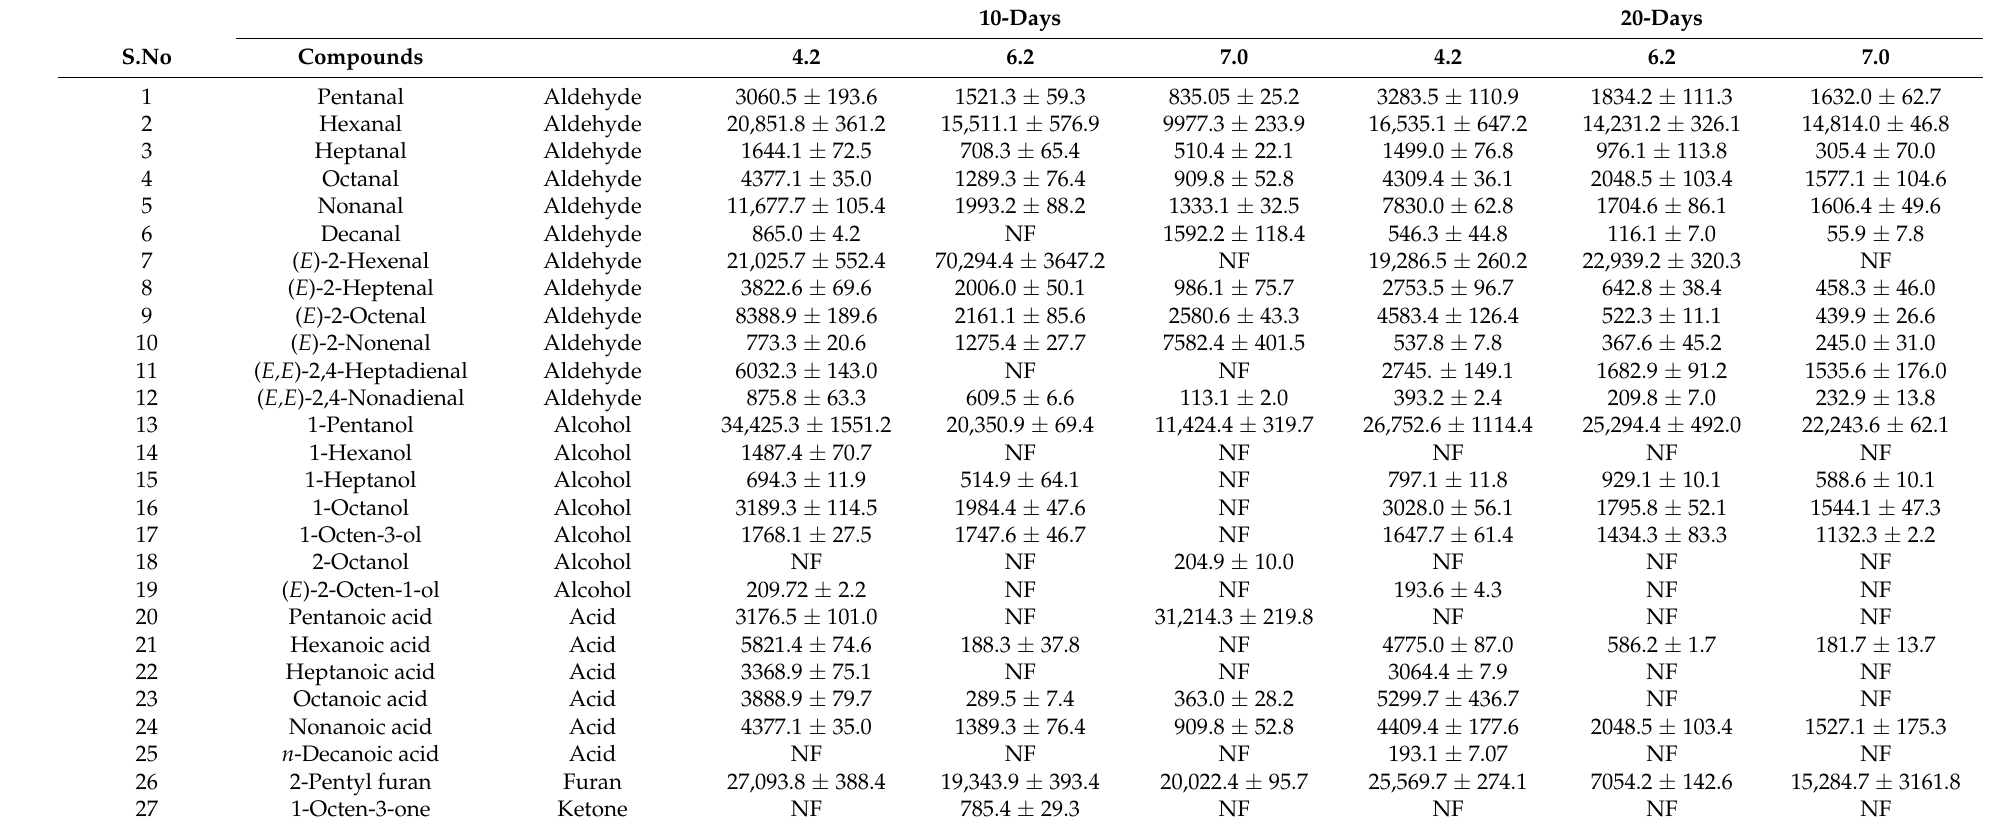
Table 2. The concentration ( µ g/L) of identified volatile compounds in Model reaction at different